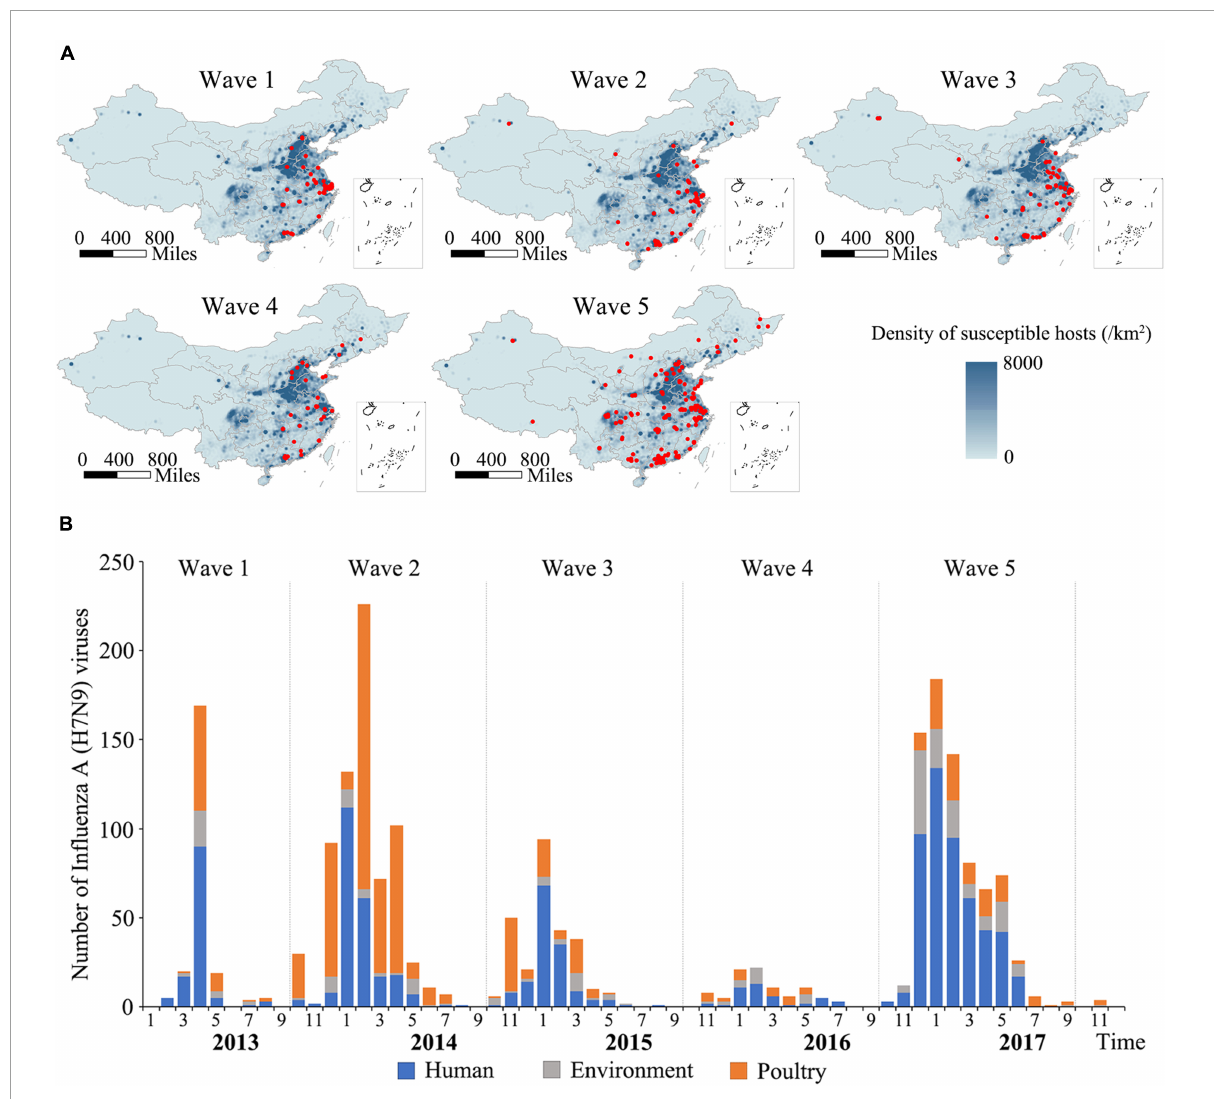
FIGURE1 Spatial and temporal distribution of Influenza H7N9 viruses during 2013–2018. (A) Geographic distribution of the H7N9 viruses isolated during Wave 1–5 in mainland, China. The red circles represent locations of the viruses isolated. The background is a population density of human and poultry. The maps were generated using QGIS 3.4 (see text footnote 7). (B) An epidemic curve of the H7N9 viruses. The curve was generated based on the monthly cumulative numbers of the H7N9 viruses isolated during 2013–2018. Viruses isolated from human, poultry, and environment are colored blue, orange, and gray,